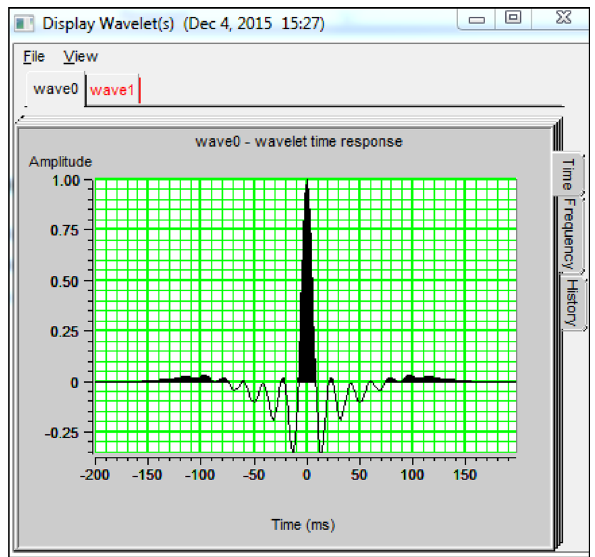
Fig. 8 Wavelet estimation from seismic and well log data